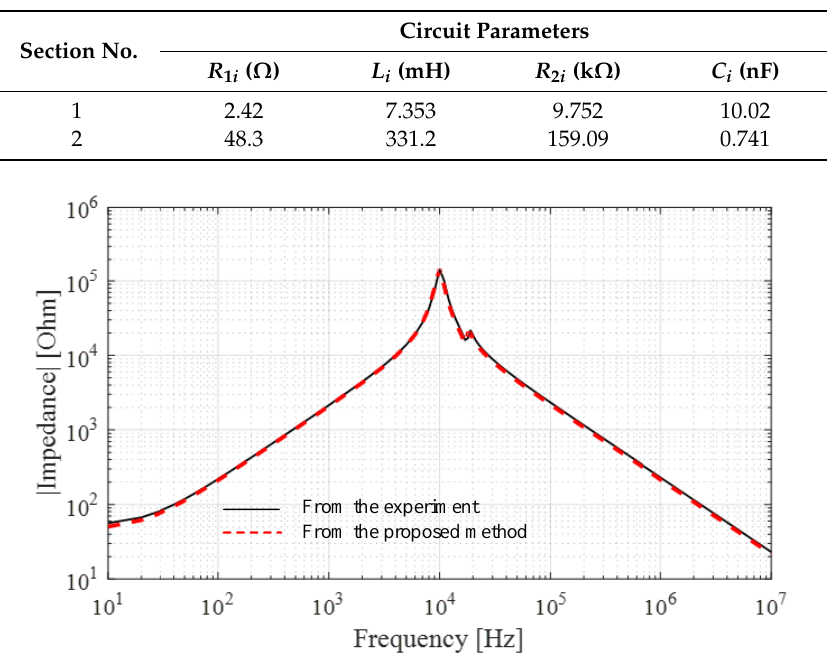
Table 8. Circuit parameters determined by the proposed approach.